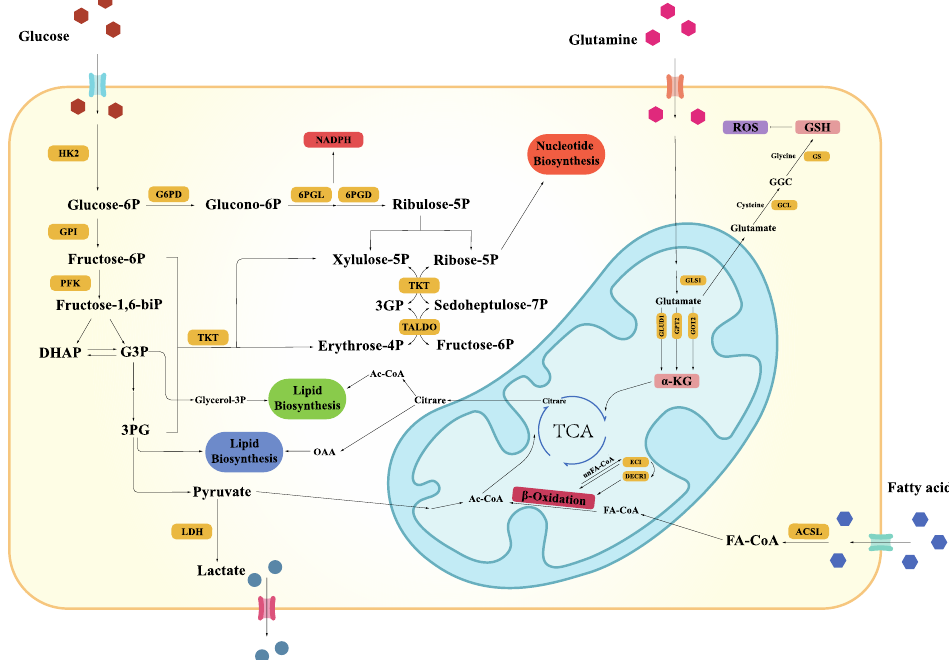
Figure 1. The metabolic reprogramming involved in mitochondria promotes the occurrence and progression of tumors. Tumor cells need more nutrients to meet the demand for survival and proliferation. Under aerobic conditions, glucose as the primary energy source is firstly converted to pyruvate by glycolysis. Pyruvate is used in lactate production, can also be used in other biosynthetic reactions, or is transported to the mitochondrial matrix to participate in the TCA cycle. As